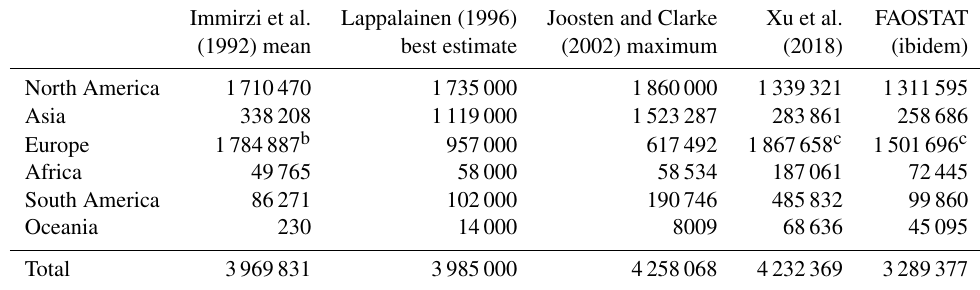
Table 6. Comparisons of published global and regional estimates for area of peat and organic soils (km 2 ) a . Immirzi et